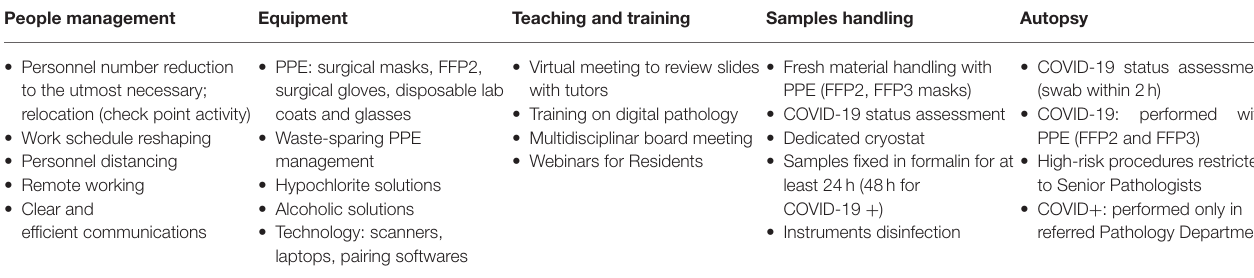
TABLE 1 | Summary of recommendations based on experience during the pandemic at